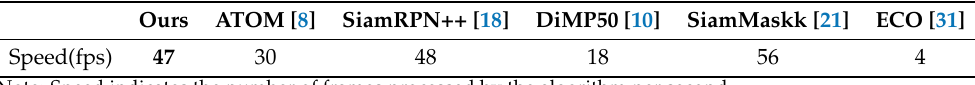
Table 3. Experimental results of the speed of our algorithm running with other algorithms on the VOT2018 dataset. The bolded values in the table are the best performance.